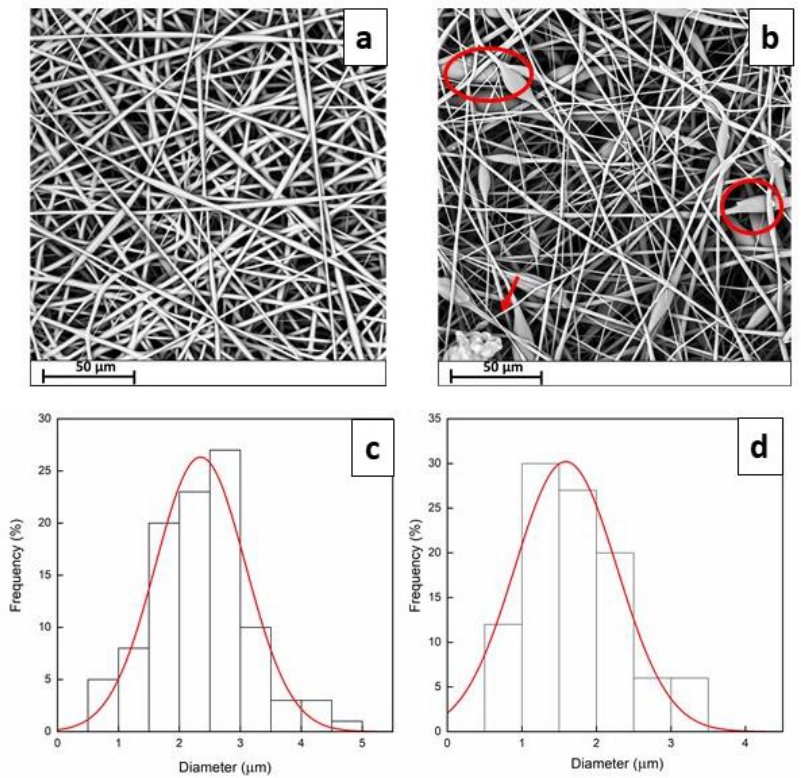
Figure 1. SEM images and diameter distributions of PCL/PVP ( a ) and Querc-PCL/PVP membranes ( b ). Distributions of diameters of PCL/PVP ( c ) and Querc-PCL/PVP ( d ). (red circles and arrows indicate the beads).